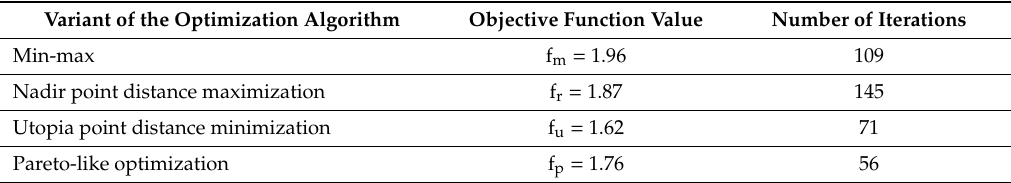
Table 1. Comparison of optimization algorithm variants in terms of performance.